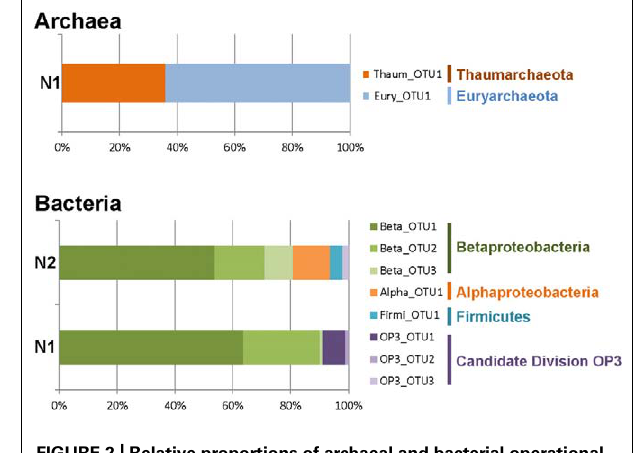
FIGURE 2 | Relative proportions of archaeal and bacterial operational taxonomic units (OTUs) distributed in major high-rank taxa from Naica deep hot springs. Archaea were only detected in sample N1. Eukaryotes were not detected in any of the two